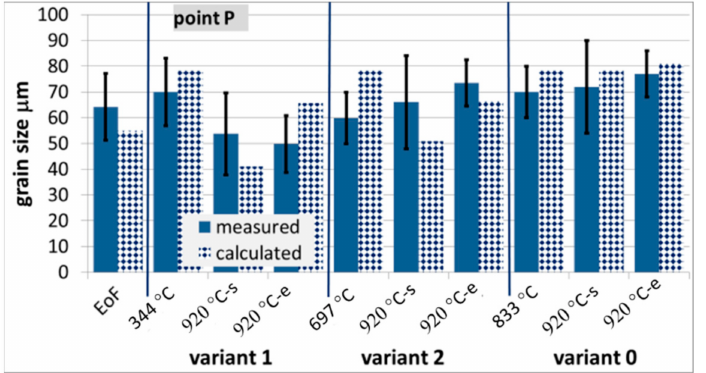
Figure 13. Measured and calculated austenite grain size at various stages of the process for steel B, EoF—end of